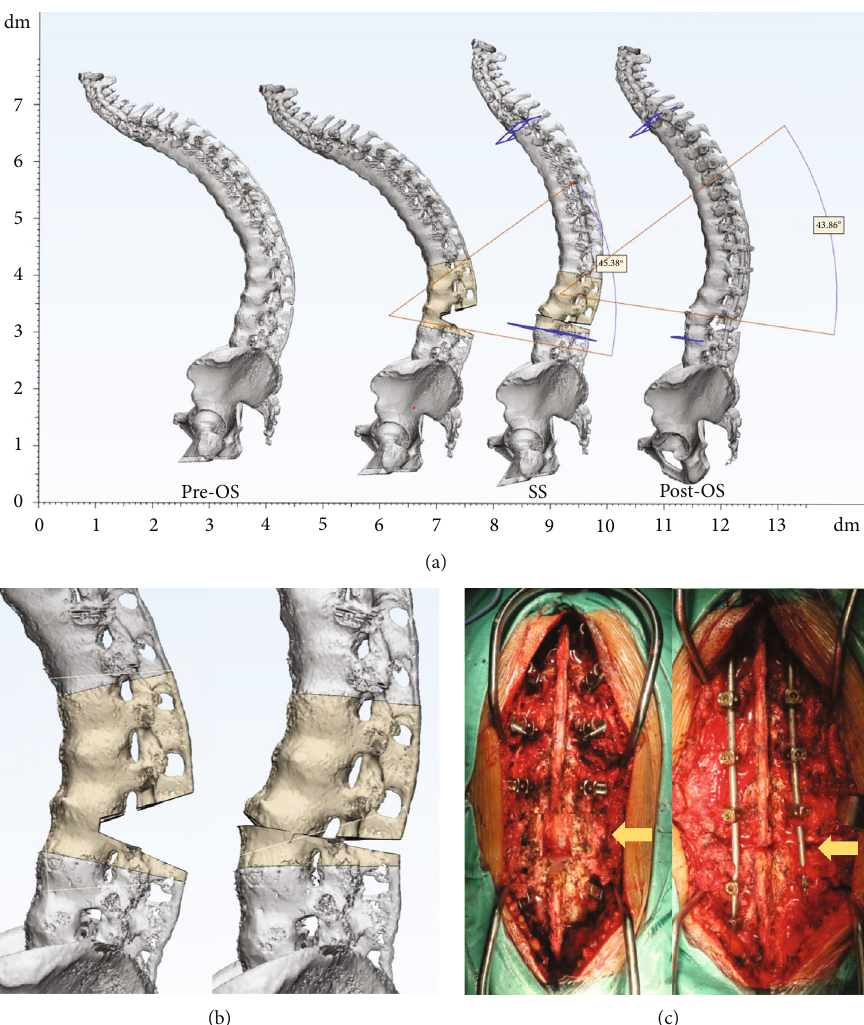
Figure 4: 3D simulation of PSO. (a) Sagittal view of the 3D spine models. (b) Partial view of PSO simulation. (c) Intra-op photographs and yellow arrows indicated L3